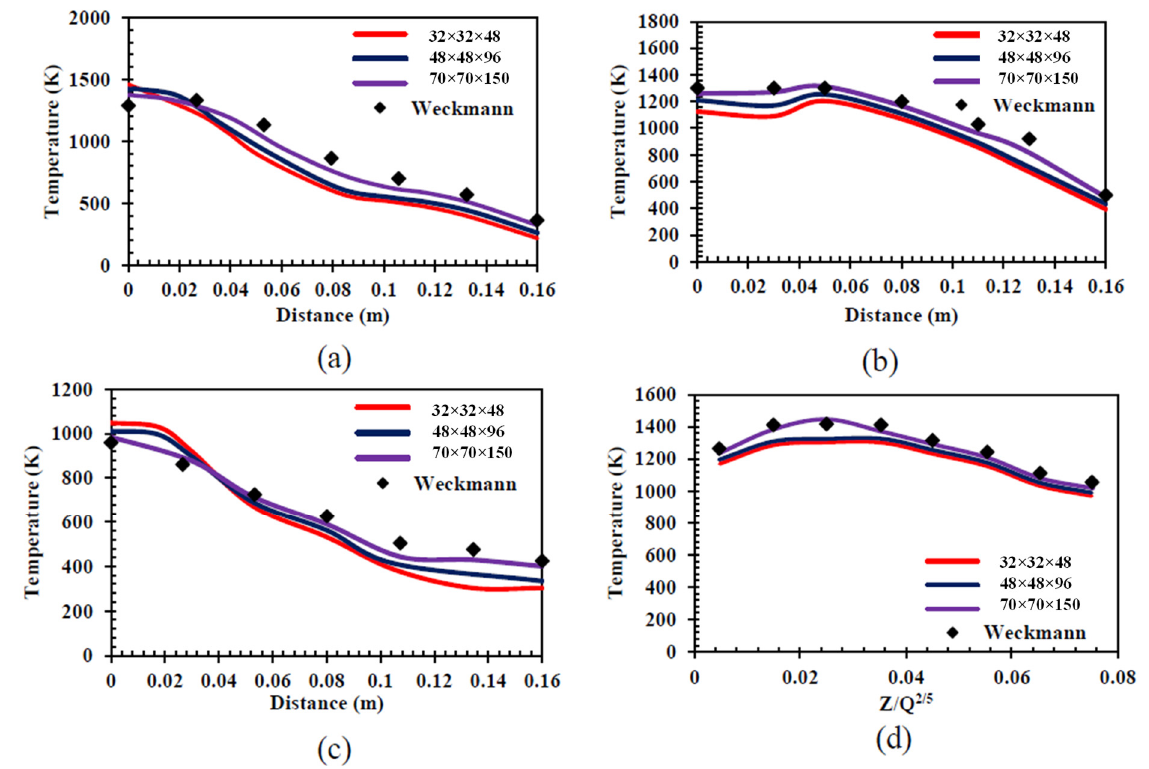
Figure 5. Comparison of temperature along horizontal centerlines at heights of ( a ) 6 cm ( b ) 12 cm ( c ) 20 cm above the plume and ( d ) hot gas layer temperature for different meshes of the present study against experimentally reported values of Weckman and Strong [17] (Experimental data adapted with permission from Weckman and Strong [17]).